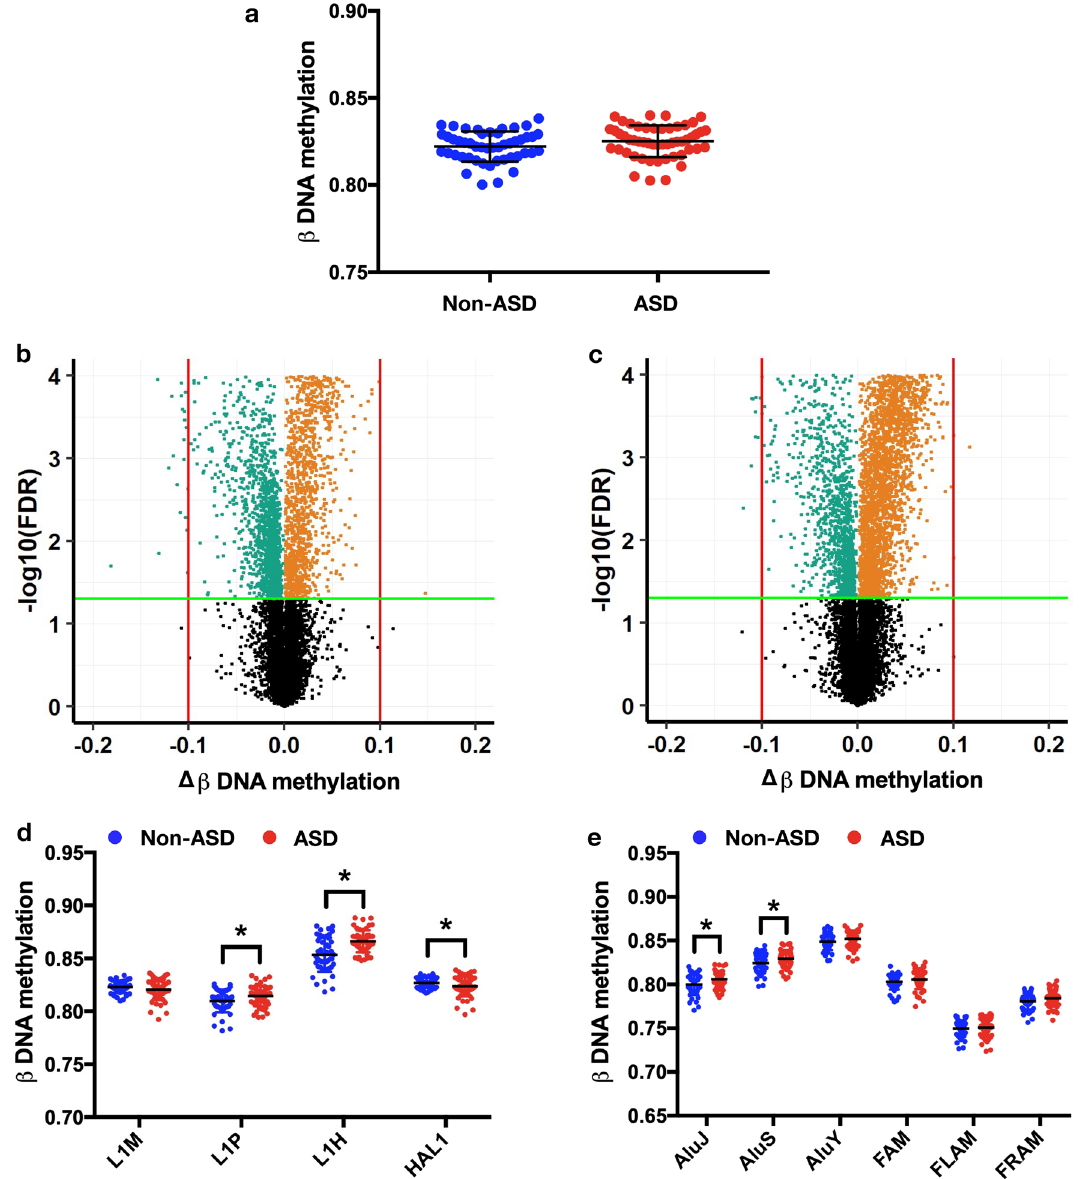
Figure 1. Methylation of repetitive elements (LINE-1 and Alu ) in non-ASD (n = 48) and ASD (n = 52). Total methylation of REs ( a ). Volcano plots of mean change in methylation (Δβ) of LINE-1 ( b ) and Alu ( c ) against − log10 FDR-adjusted p value (P FDR ) of ASD compared with non-ASD; the green line represents P FDR = 0.05, the red line represents 10% of methylation changes, green dots represent hypomethylation loci, and orange dots represent hypermethylation loci. Changes in DNA methylation (Δβ) of ASD compared with non- ASD by a subfamily of LINE-1 ( d ) and Alu ( e ). Mean ± SD. * p <